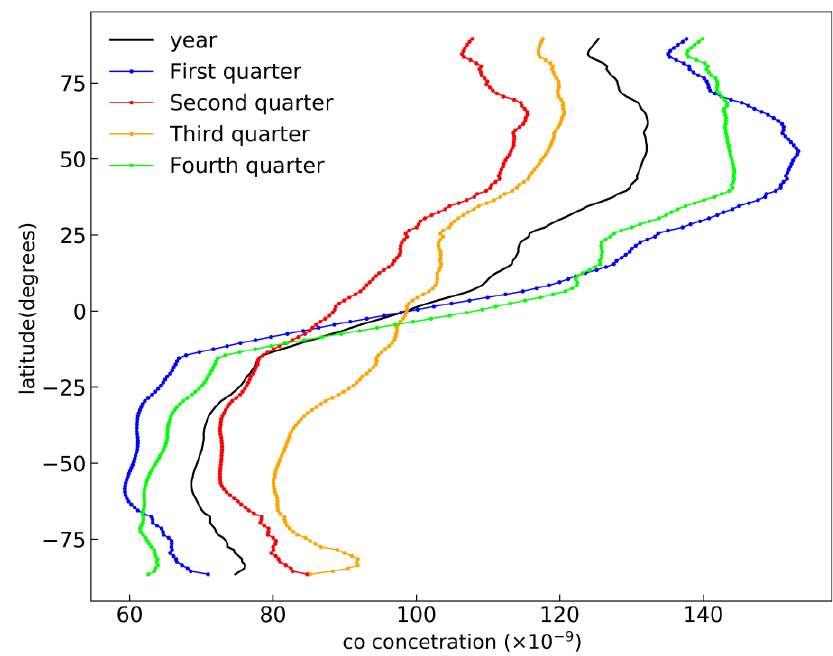
Figure 18. The zonal mean concentration distribution of global CO.